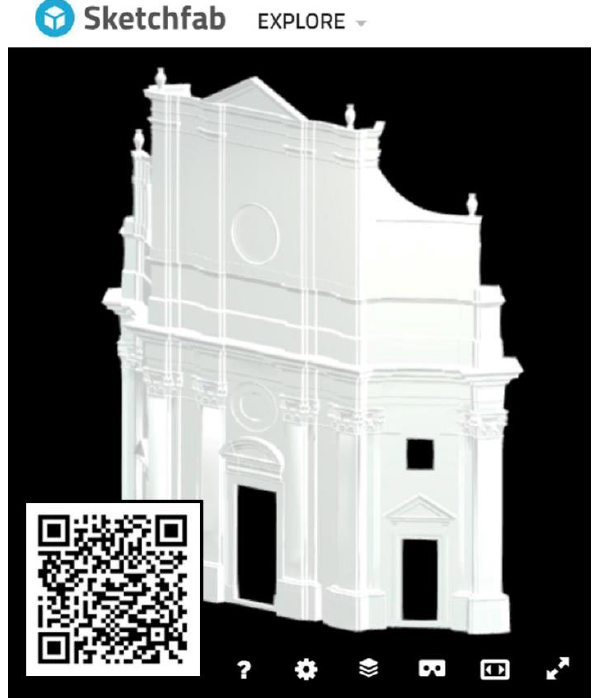
Figure 11. Example of using the model converted into a navigable mesh model on the Sketchfab